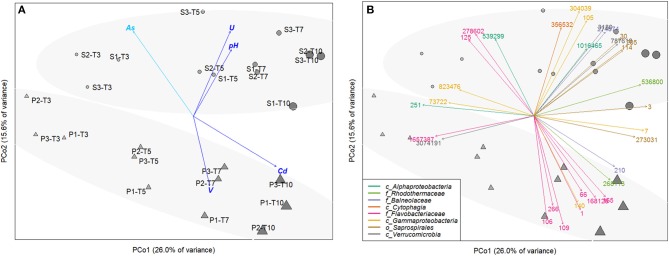
Principal Coordinate Analysis (PCoA) computed from the OTU abundance table of resuspended sediments, either exposed (P,▴) or not (S,∙) to acidic effluent (AWW), performed in triplicate (each replicate is indicated by the second digit, from 1 to 3), and collected at 4 different times along the incubation (time T3 to T10). The size and color intensity of symbols is proportional to elapsed time. Ellipses represent sample partitioning (Bray Curtis dissimilarity) between the P and S groups (standard deviation at 90% confidence, p-value 0.002). (A) Correlation between ordination and unrelated environmental variables (after removing the linearly-correlated variables). Only significant correlations are represented (p-value < 0.01, in light blue, p-value < 0.001, in dark blue). (B) Identification of 32 most discriminant OTU (labeled with their OTU number). Arrow colors represent the OTU affiliation at different taxonomic levels (class/order/family, represented by c/o/f respectively). BLAST affiliation of those OTU can be found in Table S8.